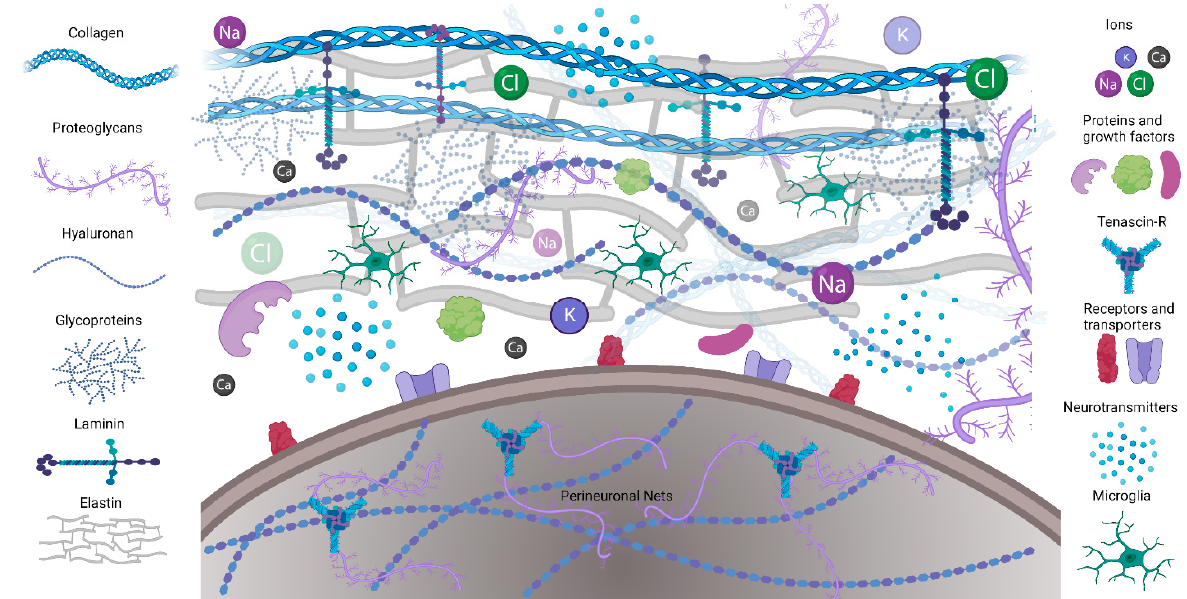
Figure 1 . Schematic illustrating the ECM composition. Extracellular matrix proteins including collagen, elastin, and laminin provide structural support and form microenvironments for neuronal and glial interactions in CNS. Perineuronal nets are formed on the cell bodies and processes of mostly inhibitory neurons.